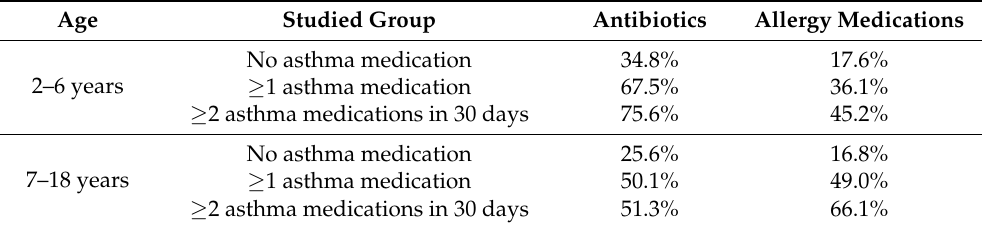
Table 3. Use of antibiotics and allergy medications by children in 2018, according to asthma medica-